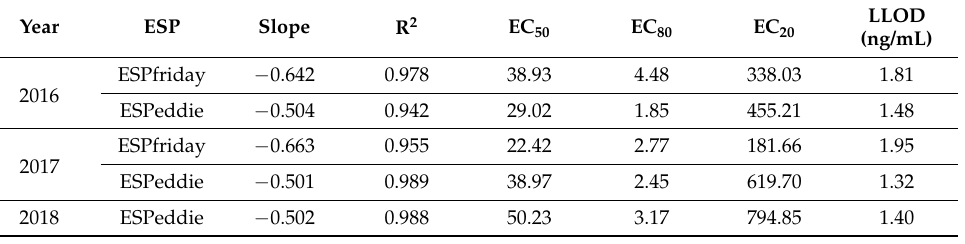
Table 2. Parameters for the domoic acid (DA) calibration curves on ESPfriday and ESPeddie in 2016, 2017, and 2018. Parameters are determined based on a 4-parameter logistic fit (variable slope) of signals generated by DA certified reference material tested at 10 concentrations ranging from 0.2 to 5000 ng/mL, as well as a 0 ng/mL negative ( n = 2 for all values). The EC 50 represents the half-maximal response, whereas the EC 80 and EC 20 represent the lower and upper limits or boundaries, respectively, of the linear dynamic range within which responses can be quantified accurately (i.e., LLOQ and ULOQ). The lower limit of detection (LLOD) refers to the lowest toxin concentration (ng/mL) that can be detected but not quantified reliably (see text for additional details).